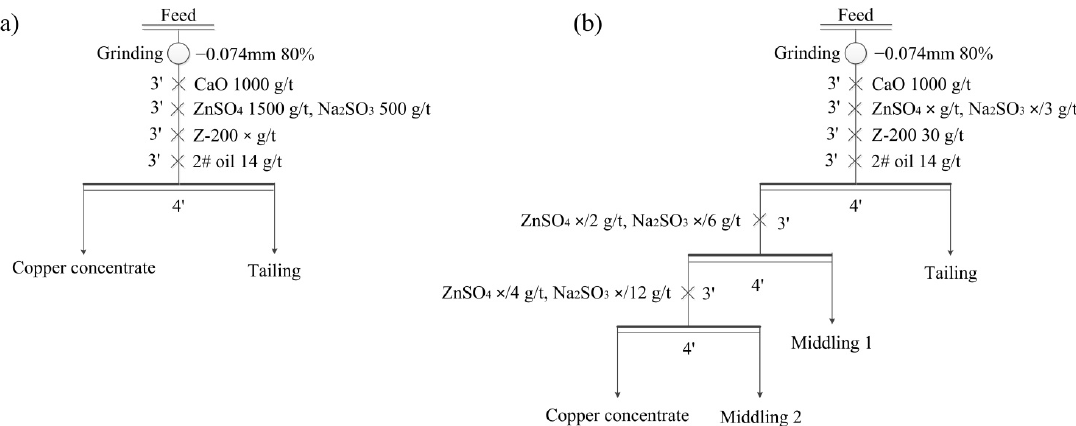
Figure 4. Experimental flow charts for the effects of Z-200 ( a ) and ZnSO 4 + Na 2 SO 3 ( b ) dosages on copper flotation.